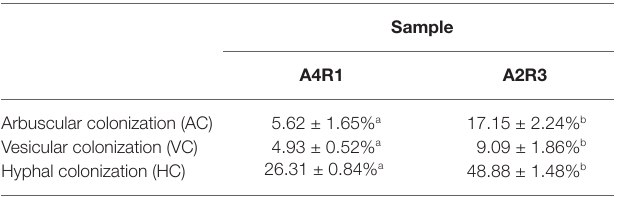
TABLE 2 | Colonization rate of mycorrhizal structures in S. arundinaceus roots at the end of the